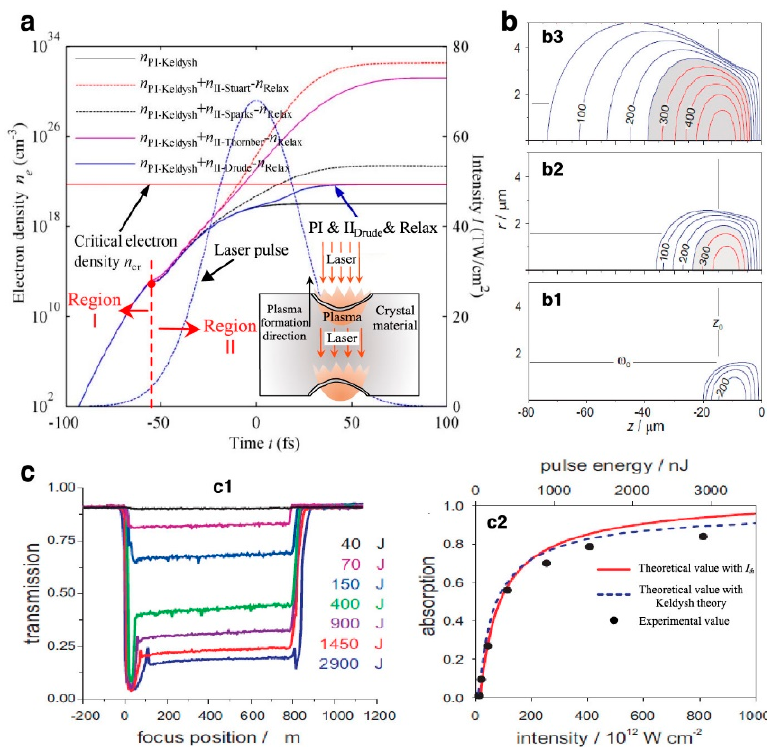
Figure 6. The process of energy deposition and evolution under femtosecond laser irradiation. ( a ) The electron density n e (t) curve of KDP materials under the femtosecond laser irradiation based on Equation (13), λ = 800 nm, τ = 55 fs, I 0 = 68 TW / cm 2 . Region I: photoionization, and Region II: avalanche ionization and formation of plasma [65]; ( b ) Deposition energy density distributions in dielectric materials predicted by nonlinear absorption model, τ = 50 fs, pulse energies and laser peak intensity of b1 100 nJ, 2.8 × 10 13 W · cm − 2 , b2 250 nJ, 7 × 10 13 W · cm − 2 , and b3 1000 nJ, 28 × 10 13 W · cm − 2 , respectively; ( c ) Influence of plasma formation on laser irradiation with c1 the transmission of high-intensity femtosecond pulse laser irradiation as a function of laser focal position, and c2 the bulk absorption as a function of the laser pulse energy [67].